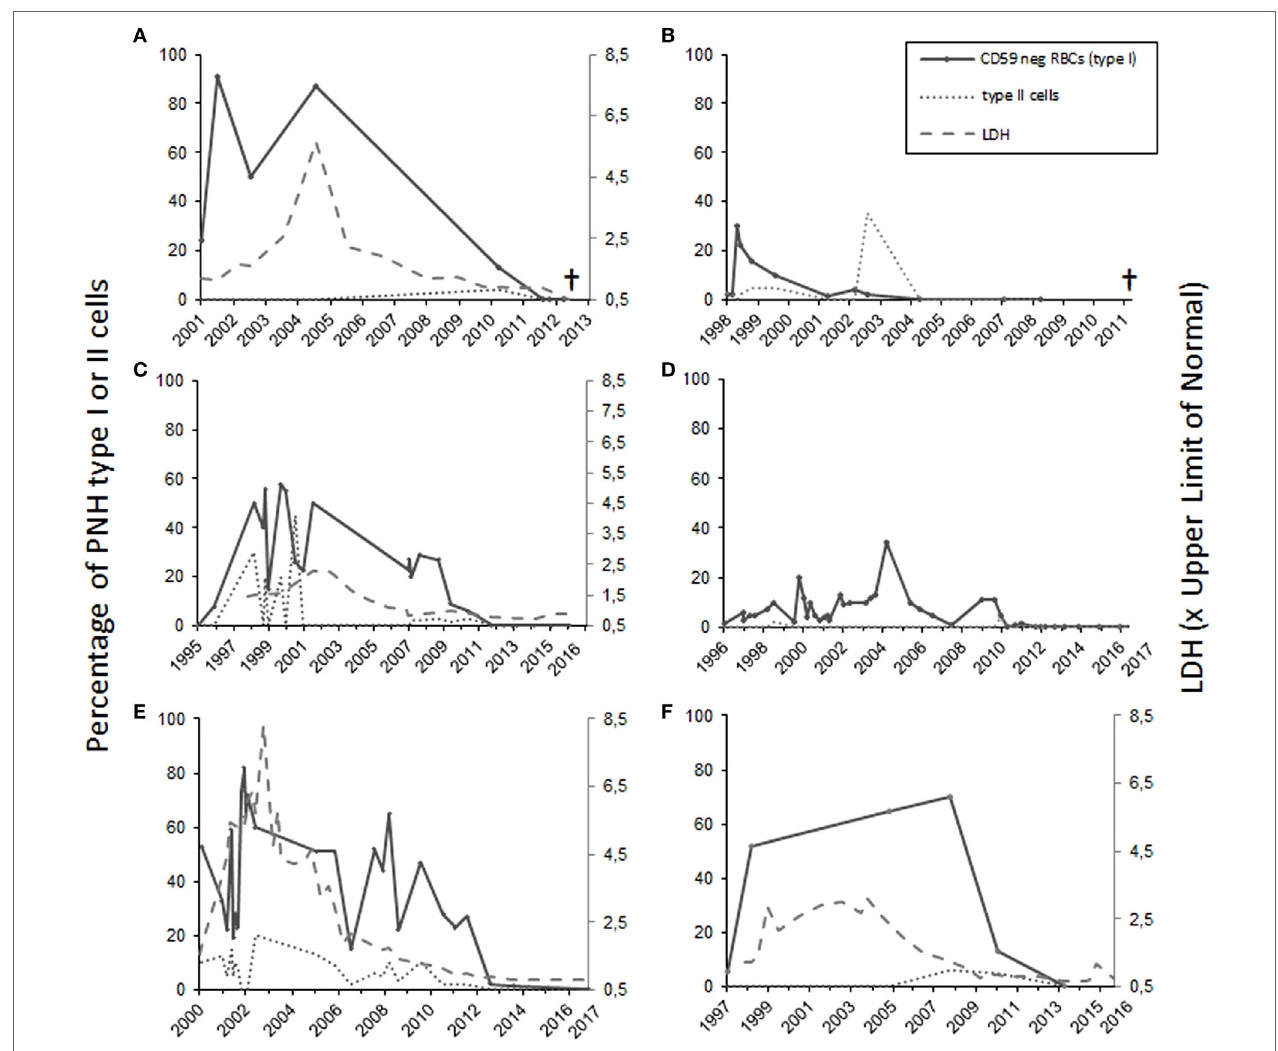
FigUre 1 | The percentage of totally and partially CD59-deficient red blood cells in patients 1–6 [ (a–F) , respectively]. For patients 1, 3, 5, and 6 who had intravascular hemolysis, the lactate dehydrogenase levels (LD) are shown at right on the Y -axis as values in relation to the upper limit of normal (a,c,e,F) . Patients 1 and 2 (a,b) suffered from leukemia and subsequently died. Patients 3–6 are in